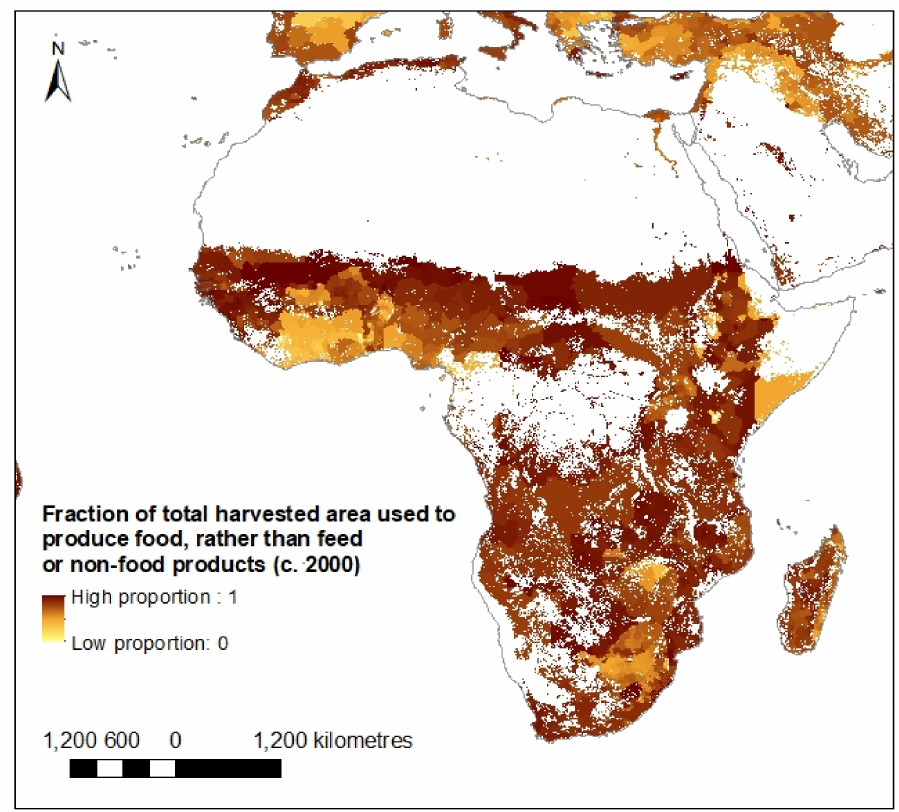
Figure 2. Map showing the fraction of total harvested area used to produce food in Africa (with the remaining fraction used for animal feed and non-food products, such as biofuel). Areas shown in white may simply represent locations for which data are unavailable. Source : Map produced using data made available by Cassidy, West [70], deemed representative of circa (c.) 2000. Maps throughout this article were created using ArcGIS®software by Esri. ArcGIS®and ArcMap are the intellectual property of Esri and are used herein under licence. Copyright © Esri. All rights reserved. For more information about Esri®software, please visit